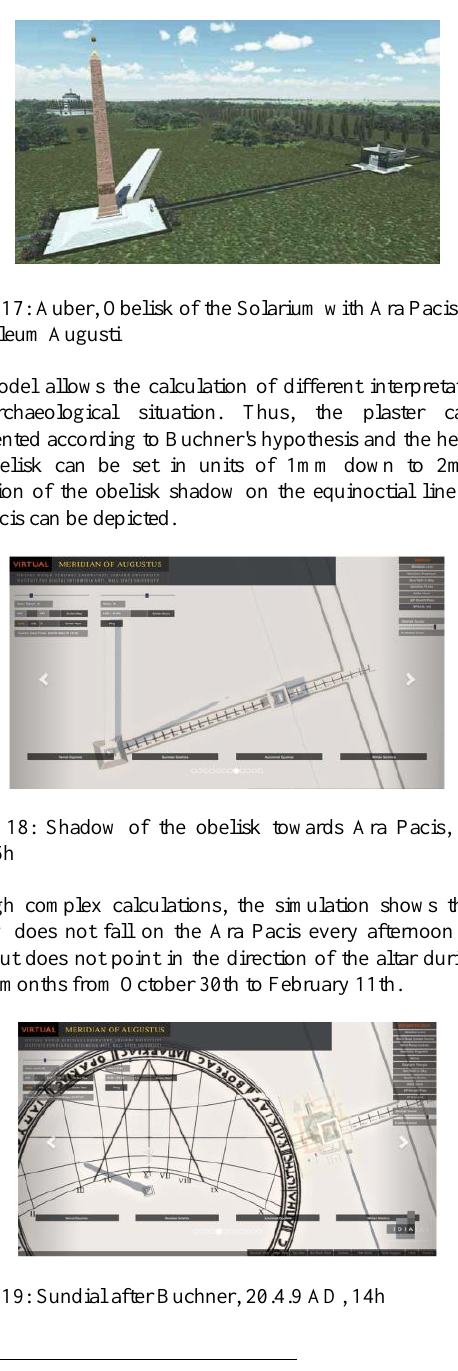
Figure 19: Sundial after Buchner, 20.4.9 AD,